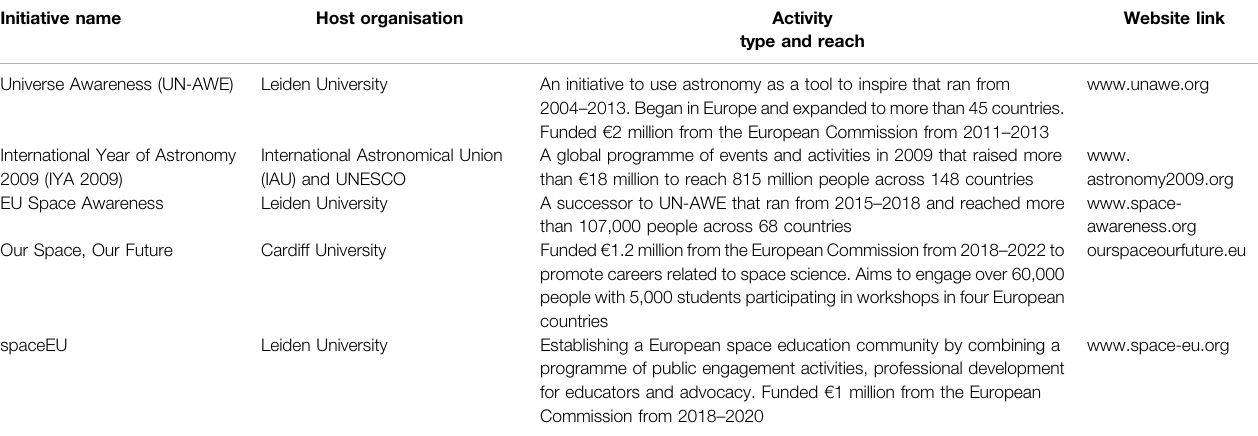
TABLE 1 | Recent international space education initiatives available to young